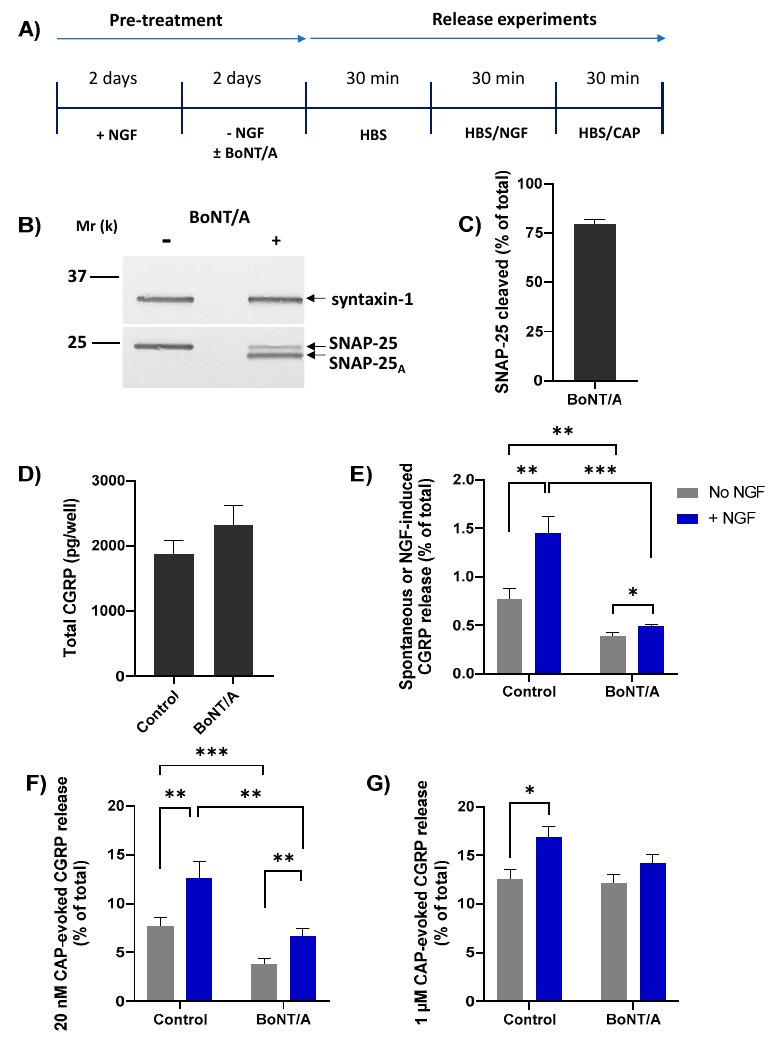
Figure 5. BoNT/A blocked NGF-induced CGRP release and -enhancement of 20 nM CAP-evoked CGRP release. ( A ) After 2 days in the presence of 50 ng/mL NGF, TGNs were starved of the neurotrophin as detailed before, without or with the inclusion of 100 nM BoNT/A during this latter step. The release experiment was performed as described in Figure 3A. ( B ) At the end of the protocol, one well each of BoNT/A-treated and non-treated cells were solubilised in 1× LDS and subjected to West- ern blotting. PVDF membranes were cut horizontally midway between the 25 k and 37 k molecular weight markers. The upper portion was exposed to antibodies reactive with syntaxin-1 (mouse mon- oclonal, 1:2000) and the lower piece probed with an antibody recognising both intact and BoNT/A- truncated SNAP-25 (mouse monoclonal, 1:3000). ( C ) The amount of cleaved SNAP-25 in BoNT/A- treated cells was calculated as a % (mean + s.e.m., N = 3) of the total SNAP-25 (intact + BoNT/A product). ( D ) Total CGRP (pg/well). ( E – G ) Histograms showing: ( E ) spontaneous CGRP release during the second 30 min. incubation into HBS without (grey bars) or induced by 100 ng/mL NGF (blue bars), ( F ) during the third period evoked by 20 nM CAP (minus the spontaneous release), and ( G ) during the third incubation with 1 µM CAP minus the spontaneous release. In all cases, CGRP release is expressed as a % of total CGRP (mean + s.e.m., N = 3, n = 9). Asterisks summarise the results of unpaired one-tailed Welch tests applied to the data plotted in panels E, F, and G, * p < 0.05, ** p < 0.01, *** p < 0.001. 2.7. Chimera/EA Inhibits CGRP Release Elicited by High [ CAP ] The/EA chimera was tested to ascertain whether it could cause a greater blockade than BoNT/A of CGRP release evoked by 1 µM CAP and its enhancement by acute NGF, using a protocol identical to the one described above for BoNT/A (Figure 5A). TGNs were starved of NGF and simultaneously incubated with 100 nM/EA before being briefly ex- posed to NGF (or control HBS) followed by stimulation with 1 µM CAP. Exposure to/EA